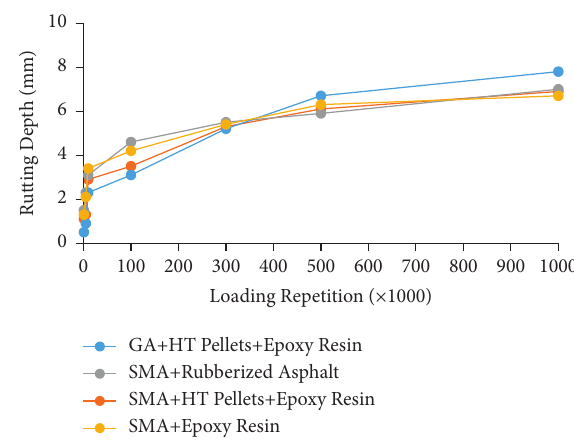
Figure 17: Rutting propagation in accelerated pavement